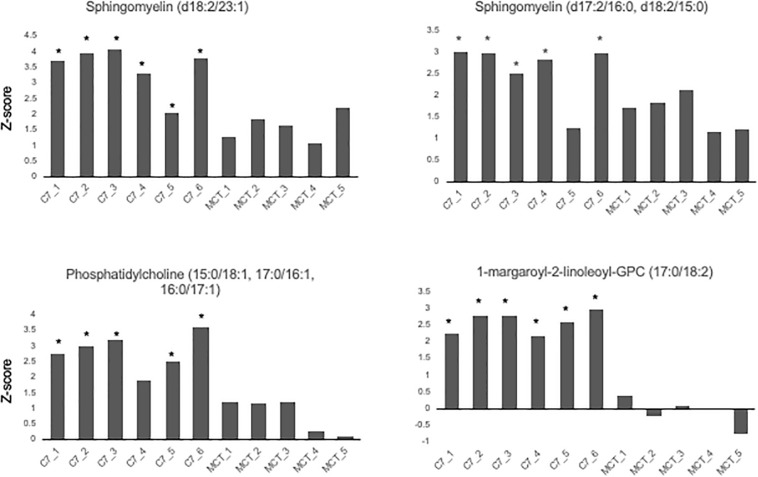
Concentrations of odd chain long-chain complex lipids in VLCAD patients treated with MCG oil (MCT 1–5) or triheptanoin (C7 1–6). The values are given as Z-score, defined as the number of standard deviations from age and sex matched control means. Compound abbreviation are as defined in Table 1.